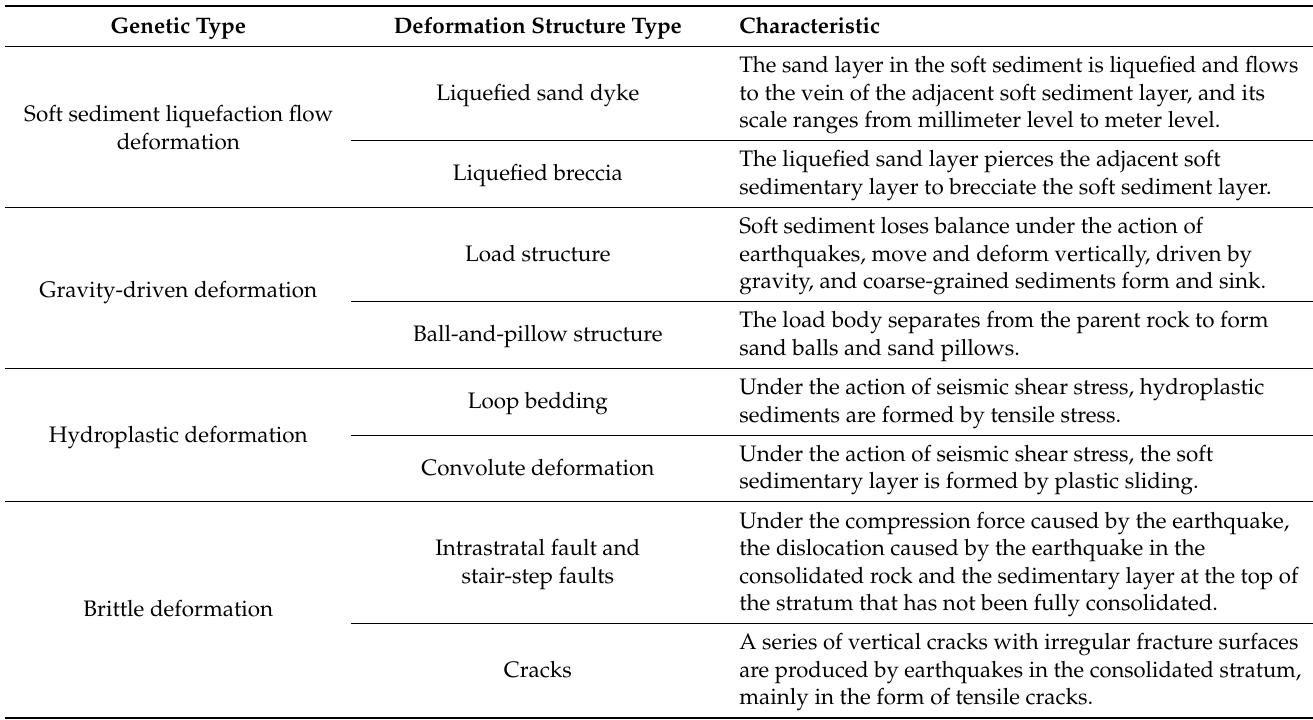
Table 1. Genetic types and characteristics of seismites in the Chang-7 Member